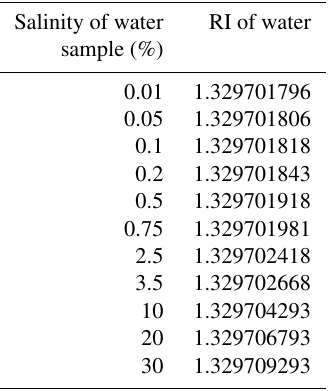
Table 2. Shows variation of RI with % of salinity of water. Salinity of water RI of water sample (%)